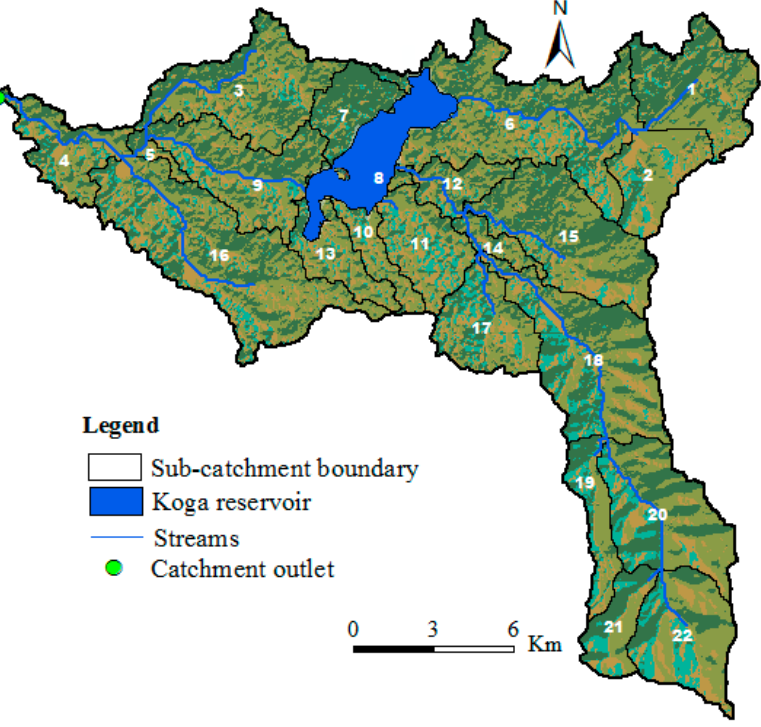
Figure 4. Koga dam reservoir and the contributing sub-catchments.